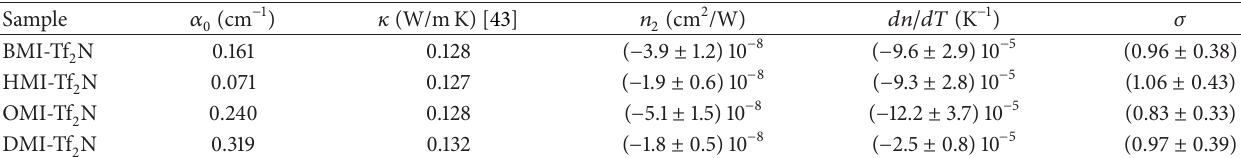
Table 1: Experimental linear absorption coefficient ( 𝛼 0 ), heat conductivity ( 𝜅 ), thermal nonlinear refractive index ( 𝑛 2 ), thermo-optical coefficient ( 𝑑𝑛/𝑑𝑇 ), and degree of nonlocality ( 𝜎 ) of the investigated ionic liquids.